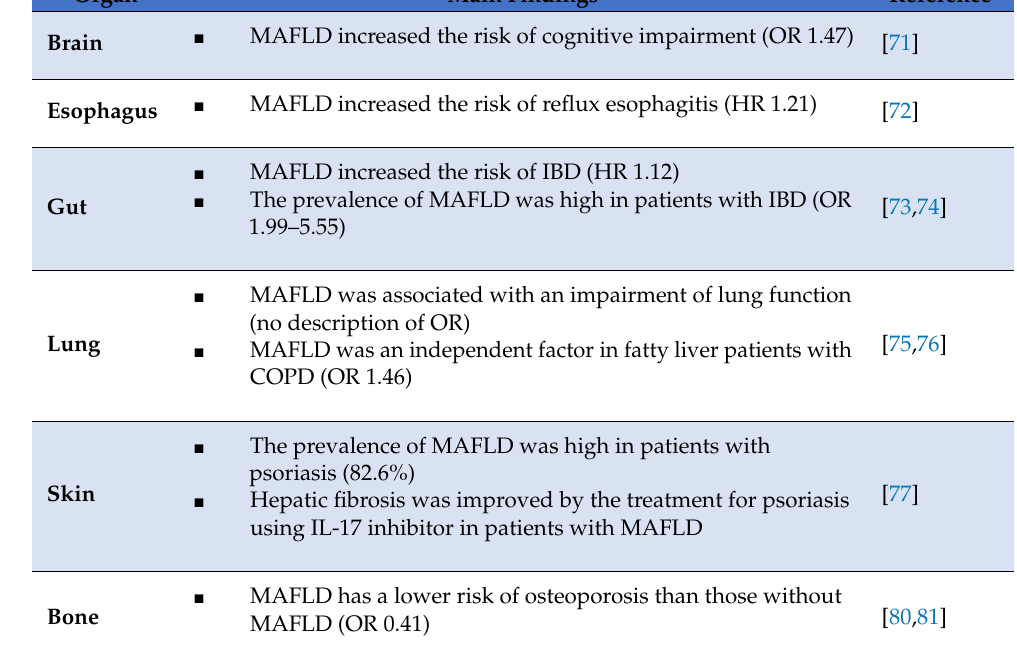
Table 6. Major findings on the relationships between MAFLD and extrahepatic organs. Organ Main Findings